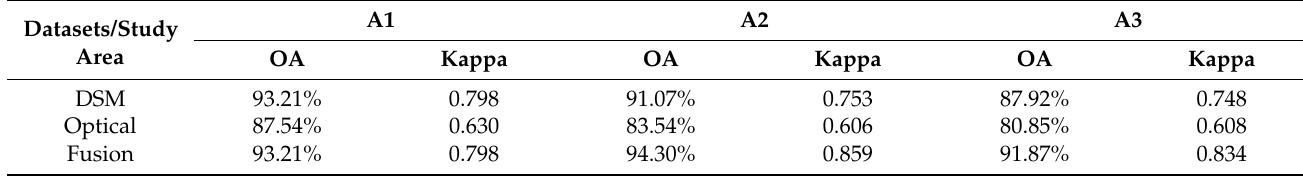
Table 4. The summary of the evaluation of the method using the OA and Kappa coefficient.